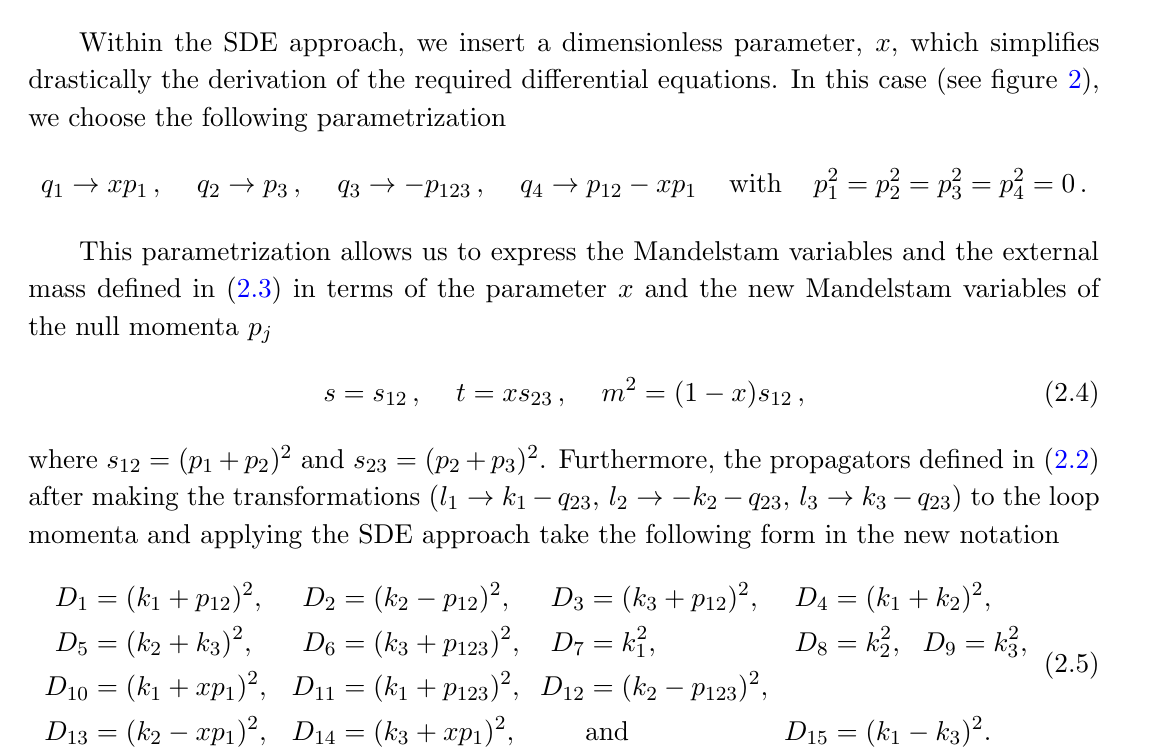
Figure 2 . The three-loop ladder-box family with one external massive leg in the SDE parametriza-